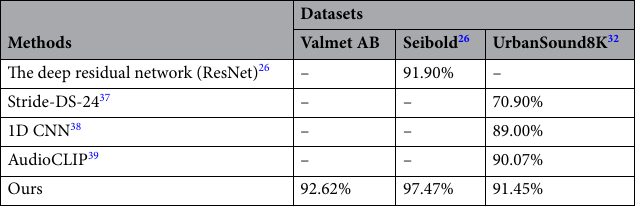
Table 2. Accuracy of different methods on Valmet’s dataset, Seibold’s dataset, and